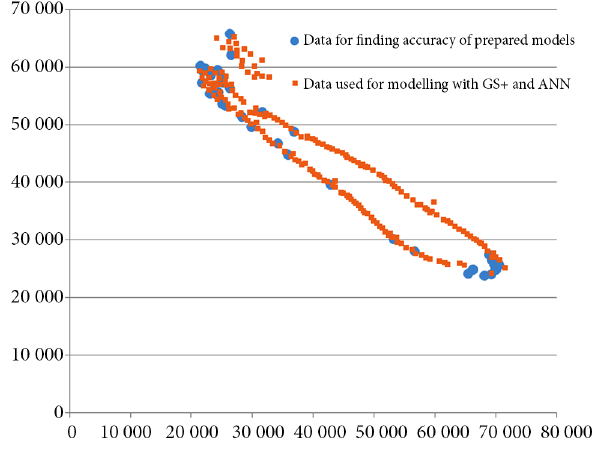
Fig. 1. Location of wellbores in the field